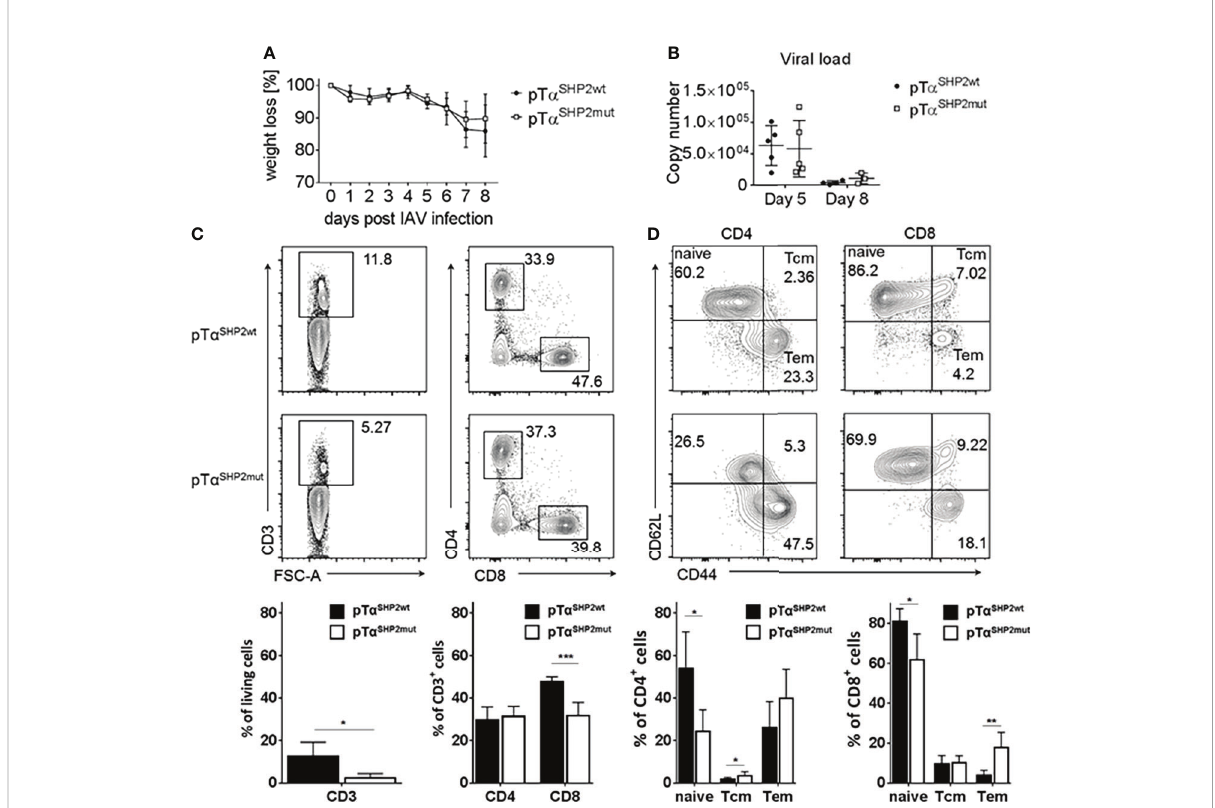
FIGURE 6 Comparable viral clearing and higher Tem frequencies in pT a SHP2mut mice. Mice were infected for 8 days with PR8-OT-I IAV. (A) Body weight was monitored throughout the course of infection (5 mice per group). (B) Mice were sacri fi ced on day 5 and day 8 to monitor viral load in the lung, representative for 5 mice per group. (C, D) Cells were isolated from bone marrow and gated on single living CD3 + , CD8 + , CD4 + and CD44 high CD62L low Tem as well as CD44 high CD62L high Tcm. Data is representative for 2 independent experiments with n=4 mice per group. (*p<0.05, **p<0.01, ***p<0.001, Student ’ s t-test, mean +